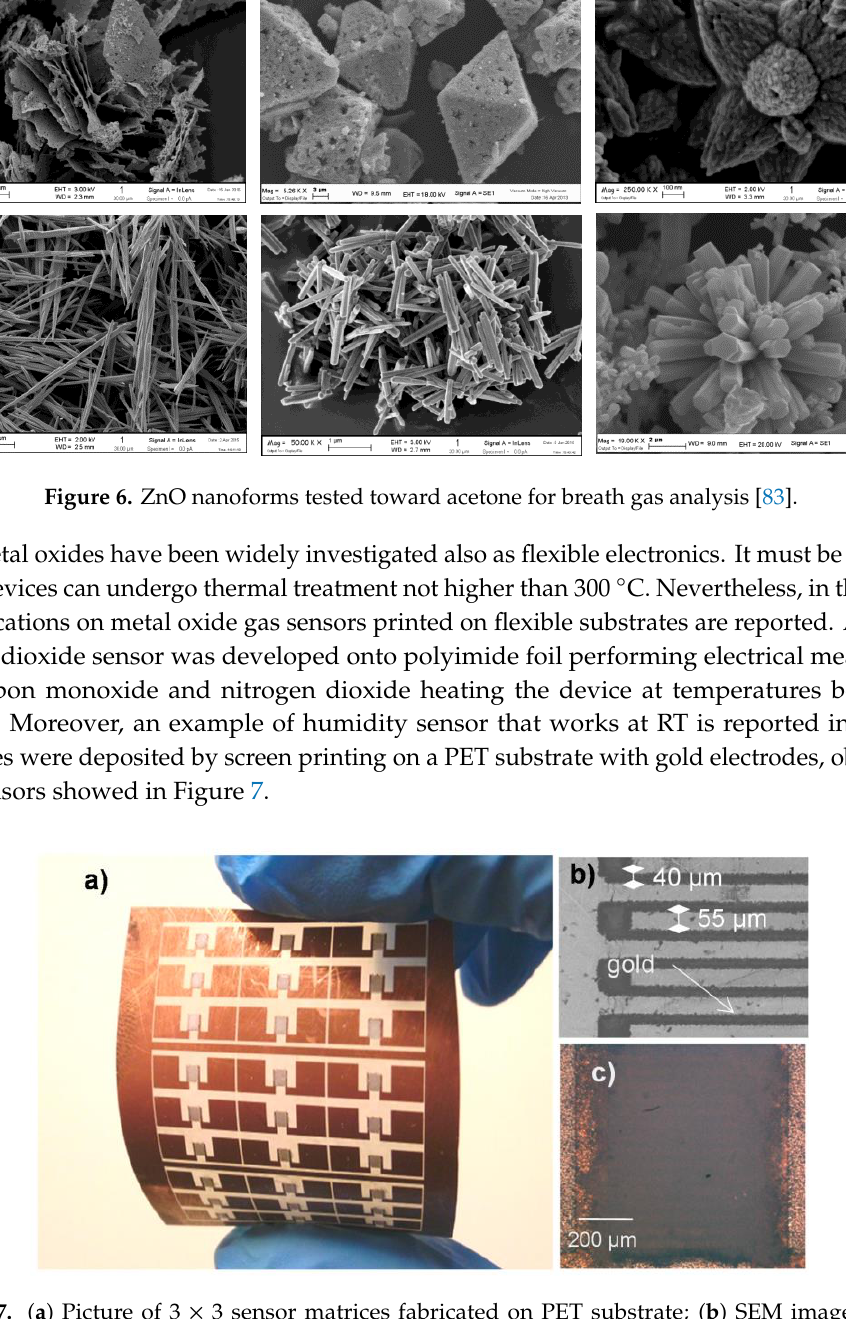
Figure 6. ZnO nanoforms tested toward acetone for breath gas analysis [83].